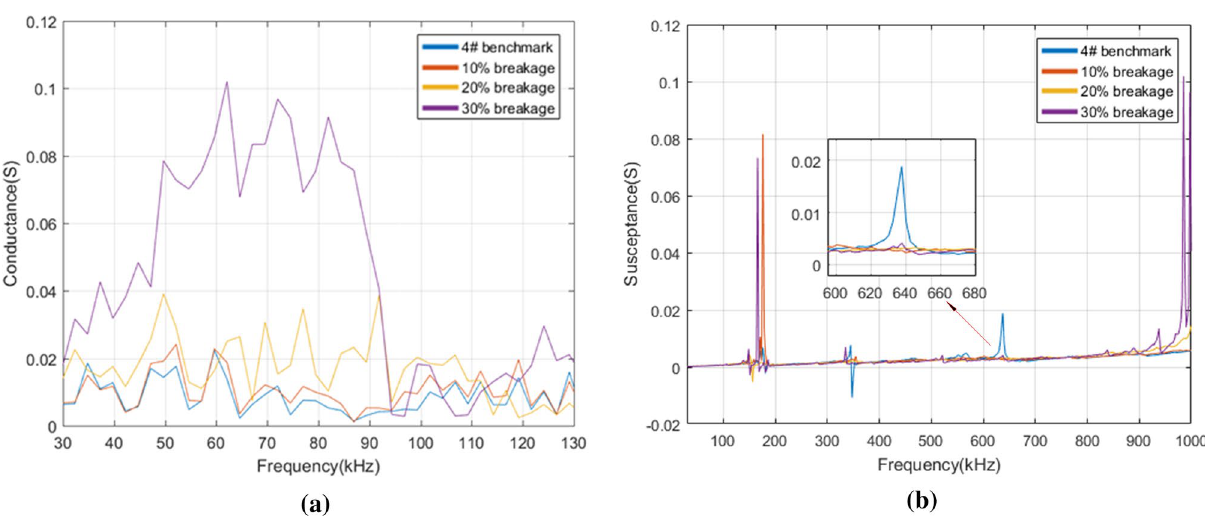
Figure 11. ( a ) The conductance and ( b ) the susceptance of 4# PZT under healthy and different breakage